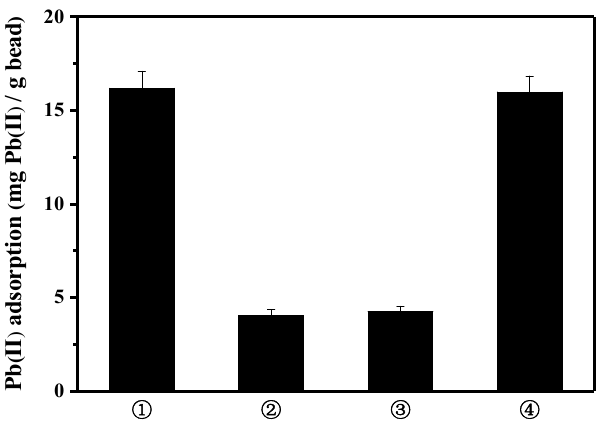
Figure 1. Pb(II) adsorption onto bare bead (mg Pb(II)/g bead): ① Dynabeads ® M-270 Carboxylic Acid; ② AccuBeadTM COOH magnetic bead; ③ Cytodiagnostic ZeptoTM Mag Carboxyl Microspheres; and ④ BcMagTM long-arm carboxy-terminated magnetic bead.